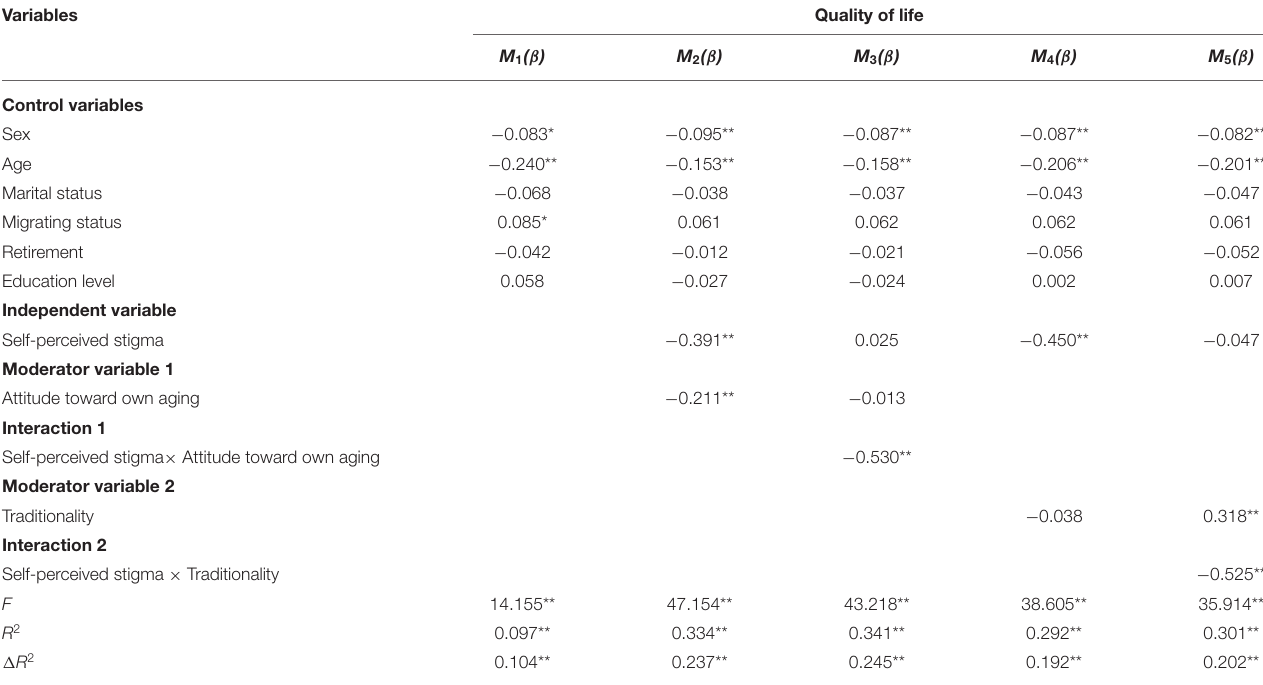
TABLE 3 | Hierarchical linear regression